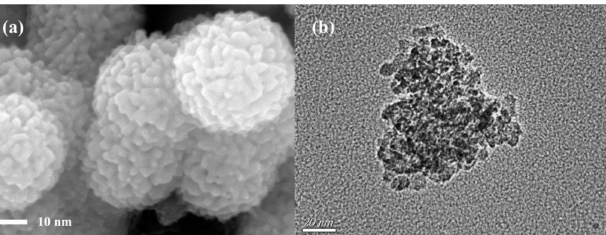
Figure 1. SEM morphology ( a ) and TEM image ( b ) of Fe 2 O 3 /Fe 3 O 4 heterogeneous nanoparticles calcined at 350 ◦ C for 2 h with the heating rate of 3 ◦ C/min and the molar ratio of ferric nitrate and urea of